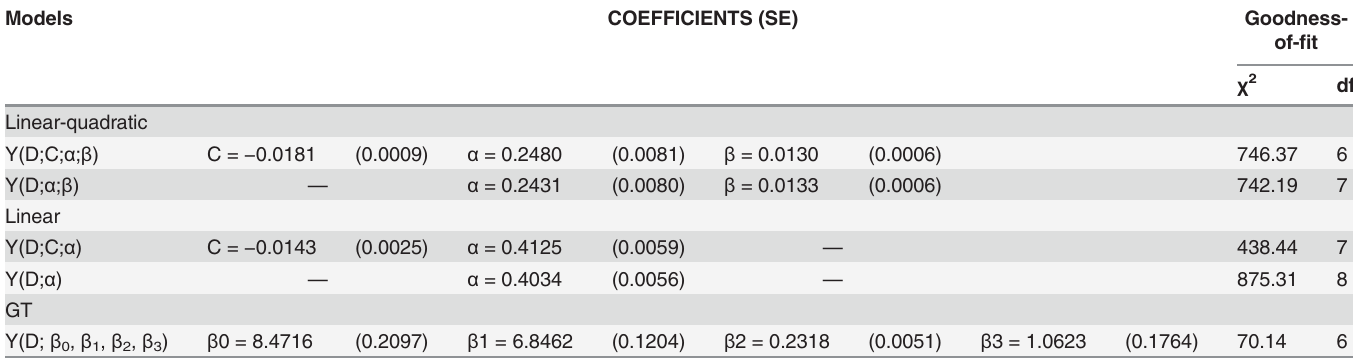
Table 3. Dose-response coef fi cients obtained for the different adjustments to the models and their goodness-of- fi t χ 2 statistics.